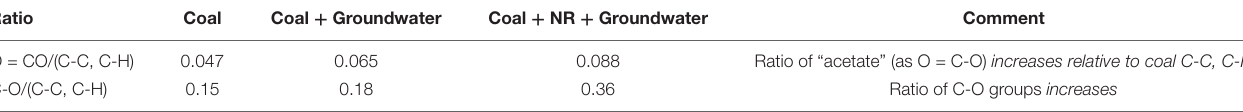
TABLE 1 | Ratio of XPS peaks to show the influence of microbes on coal.